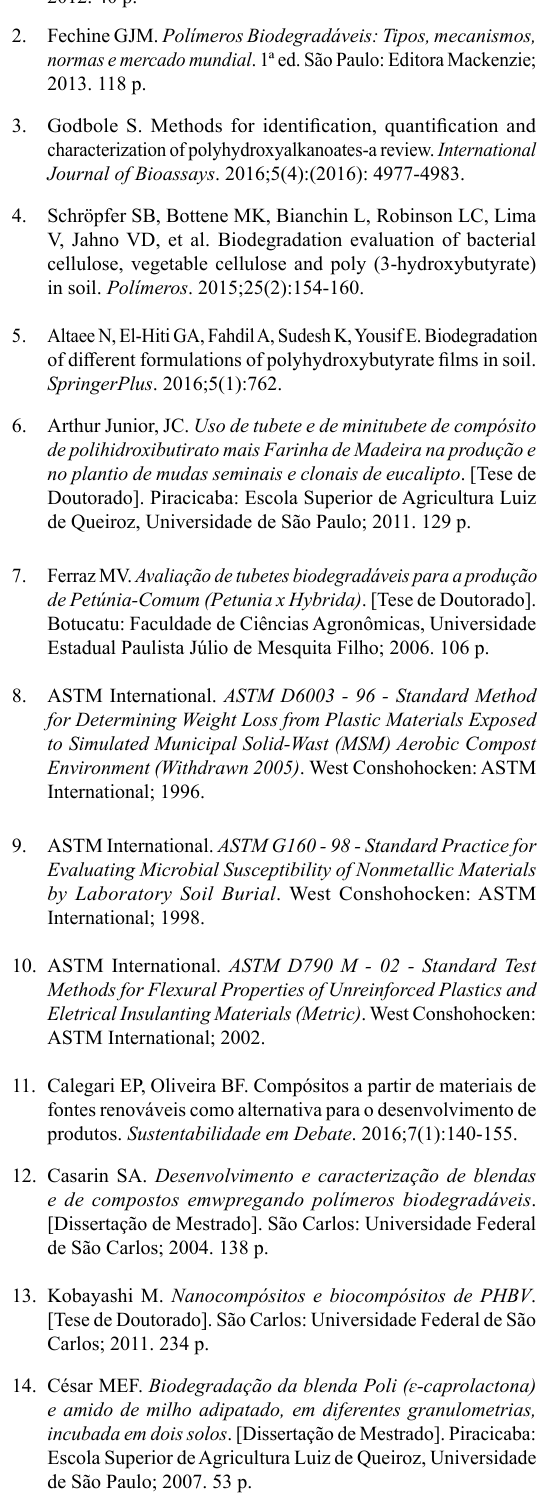
Table 2. Results of the flexural test.